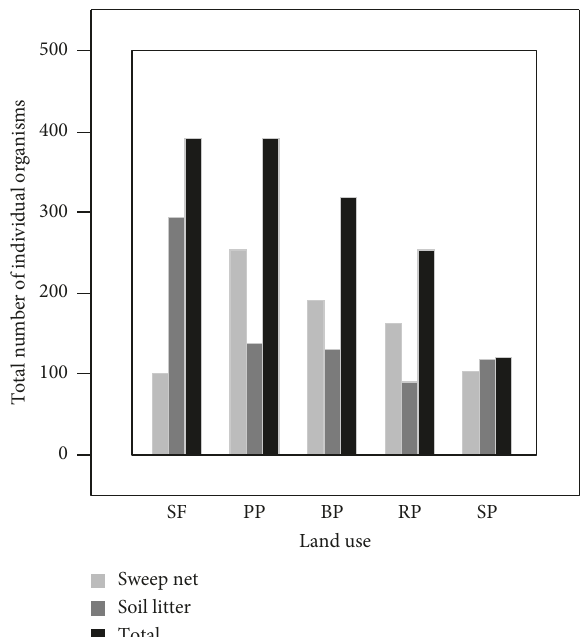
Figure 3: Total number of individual organisms collected from sweep nets and soil litter from different land-use systems.